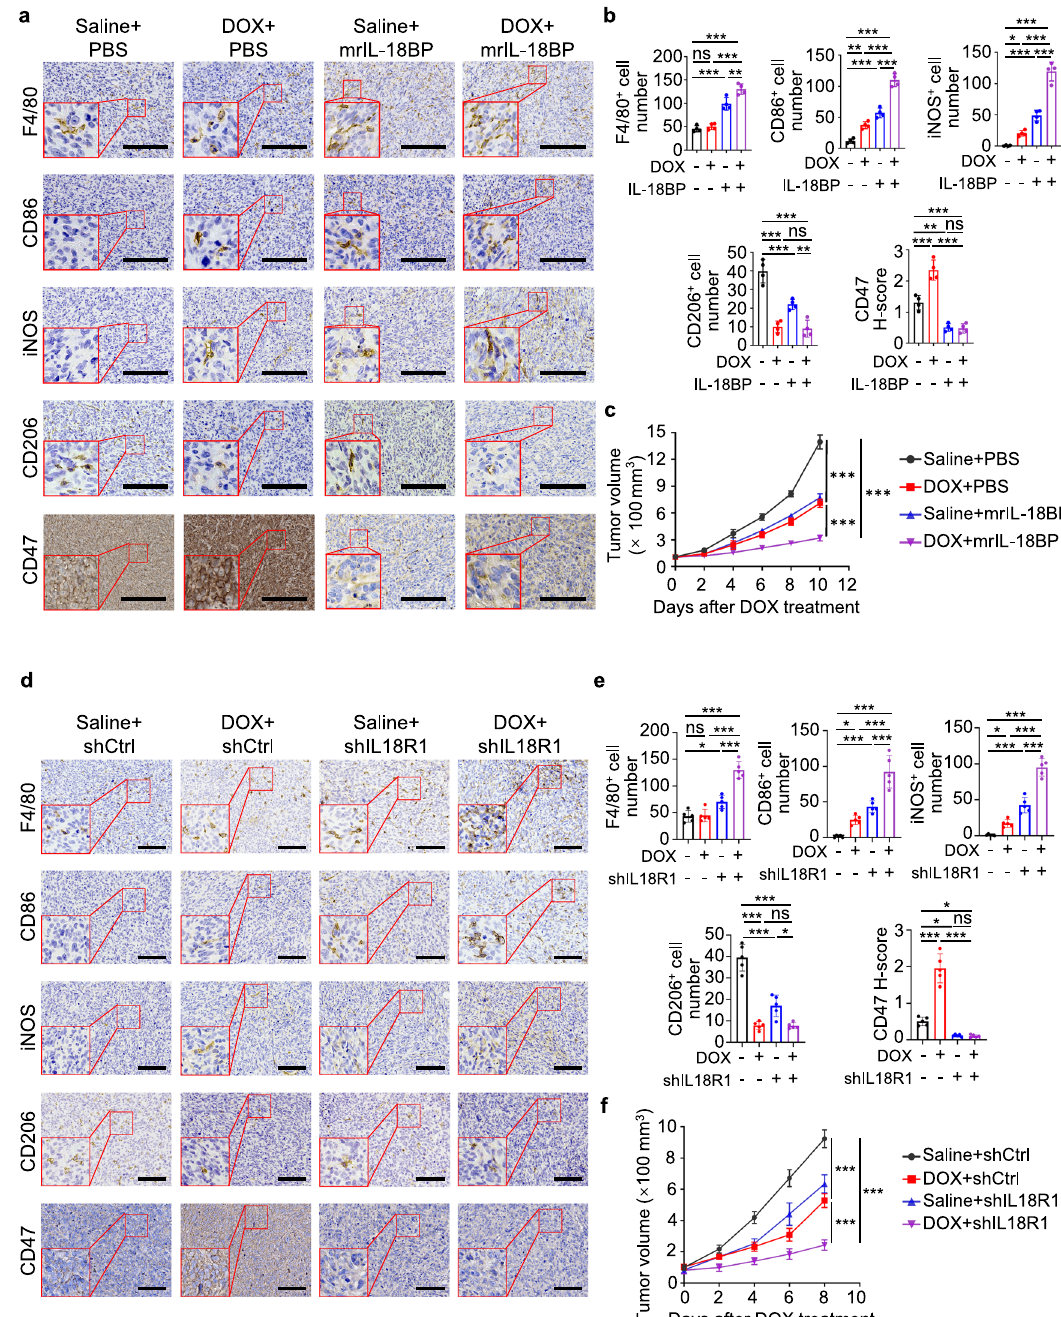
immunohistochemical images, showing F4/80, CD86, iNOS, CD206, and CD47 expression in serial sections of HOS tumors on day 22. Scale bar, 300 μ m. e Statistical analyses of quanti fi cation of d ( n =5 mice per group). f Tumor growth of HOS cells in mice ( n =5 mice per group). Tumor volume was measured at the indicatedtimepoints.Dataareshownasthemean±SD.nsnotsigni fi cant.* P <0.05, ** P <0.01, *** P <0.001, one-way ANOVA ( b , e ) or two-way ANOVA ( c , f ). The experiment was performed three times with similar results ( a – f ). See the Source Data fi le for the exact P values. Source data are provided as a Source Data fi